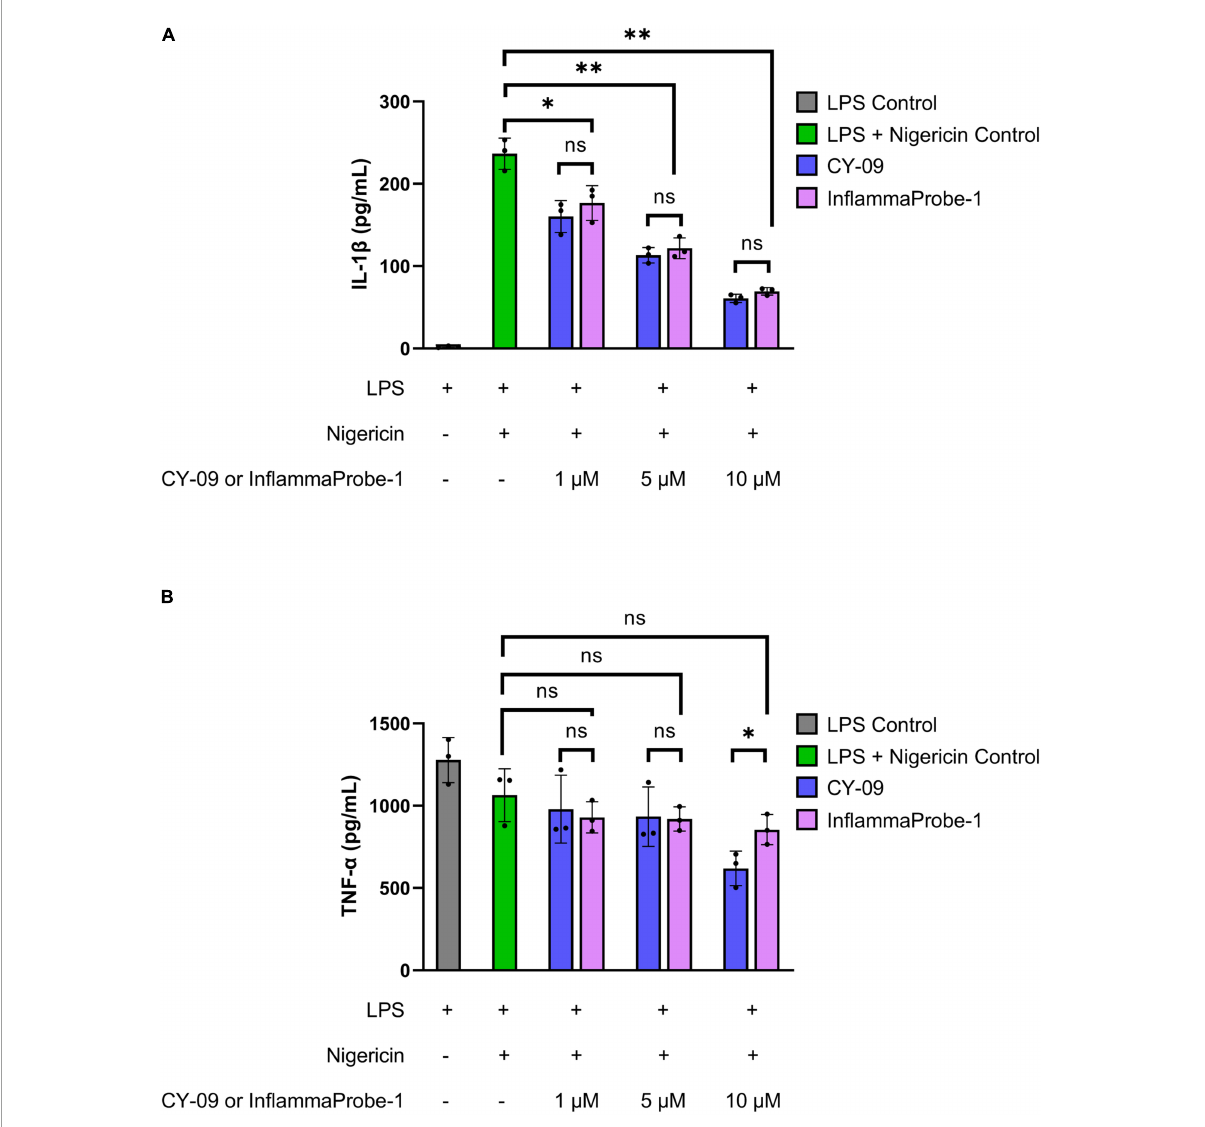
FIGURE2 InflammaProbe-1 inhibits NLRP3-mediated secretion of IL-1 β but not TNF- α . (A) InflammaProbe-1 and CY-09 dose-dependently inhibited NLRP3-mediated secretion of IL-1 β in LPS-primed and nigericin-stimulated mouse bone marrow-derived macrophages. (B) InflammaProbe-1 and CY-09 had no significant effect on LPS-induced secretion of TNF- α in comparison to the LPS and nigericin control, except for CY-09 at 10 µ M. These data suggest that InflammaProbe-1 retains the inhibitory ability of its parent compound, CY-09, that enables it to target the NLRP3 inflammasome. Levels of IL-1 β and TNF- α were measured by performing ELISA. The data were expressed as the mean ± SD ( n = 3). Statistical analysis by unpaired t -tests with Welch’s corrections; ∗ p < 0.05 and ∗∗ p <